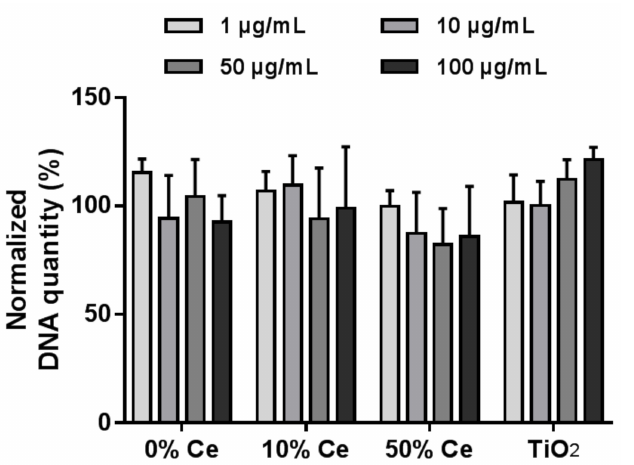
Figure 4. Cellular DNA quantification of RAW 264.7 macrophages exposed to Gd 2(1 − x ) Ce x O 2 S and TiO 2 P25 nanoparticles at different concentrations during 24 h. The cellular DNA contents were reported as percentages of that of unexposed cells. The experiments were repeated at least three